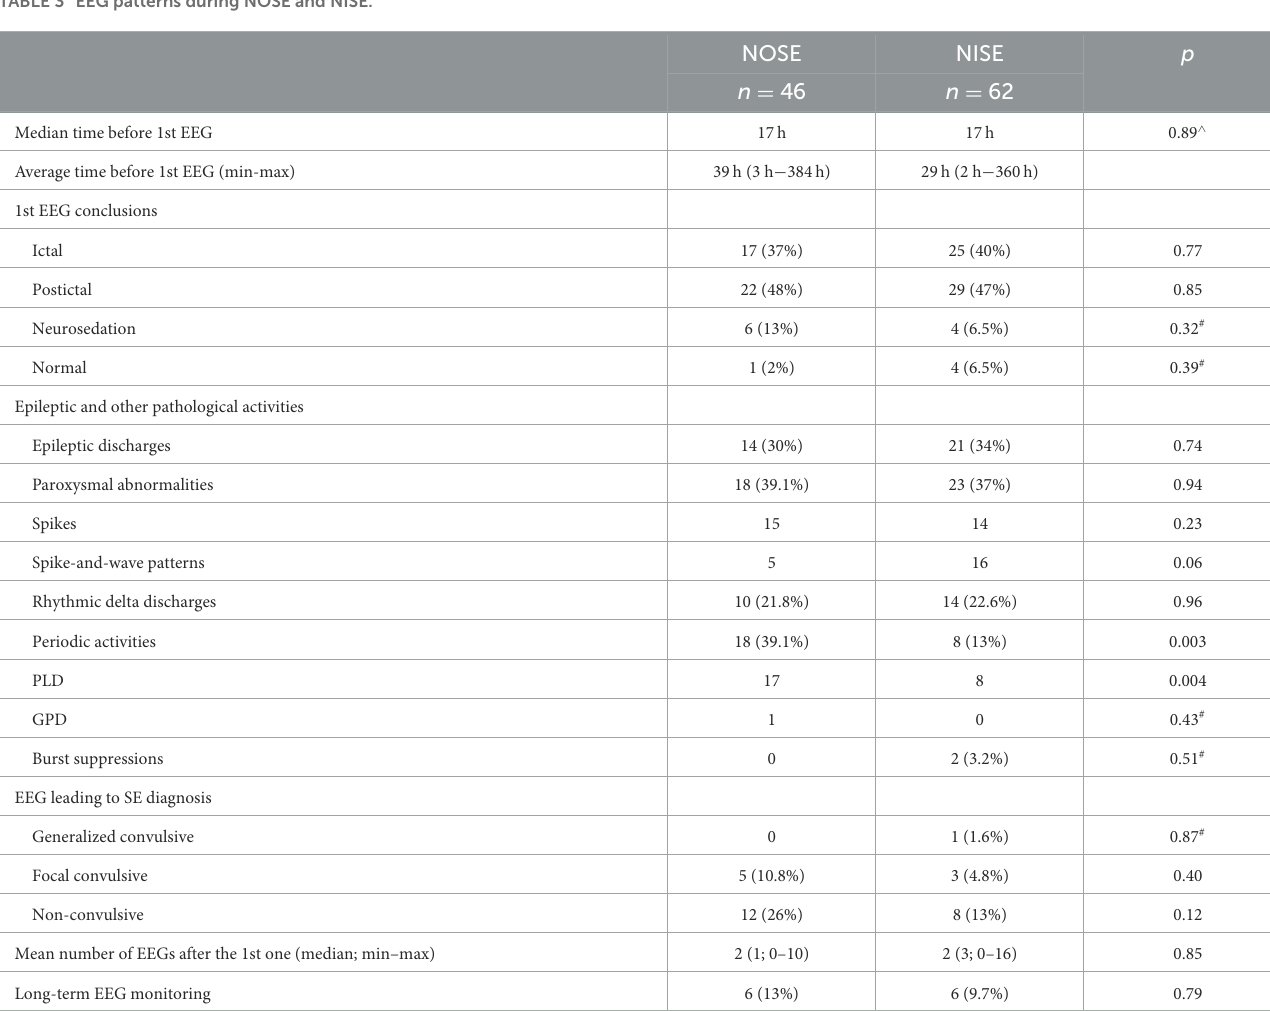
TABLE 3 EEG patterns during NOSE and